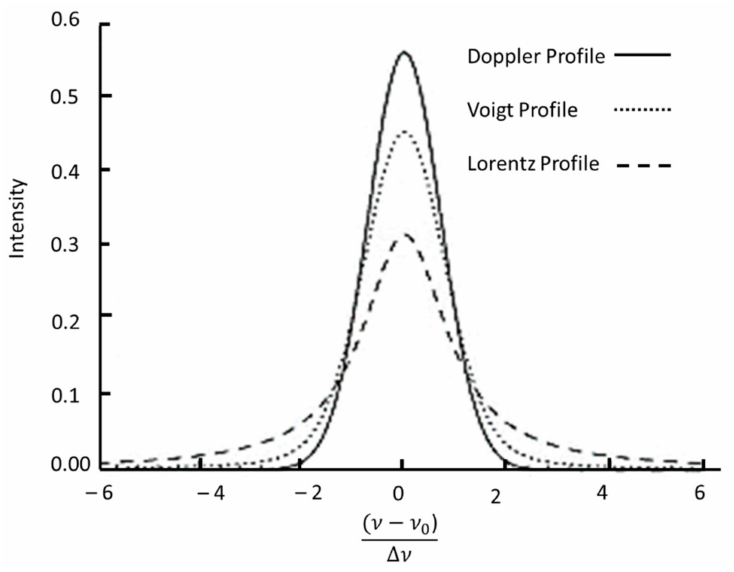
Figure 8. Absorption line profiles, Doppler, Voigt, and Lorentz. From [32], reproduced with permission.